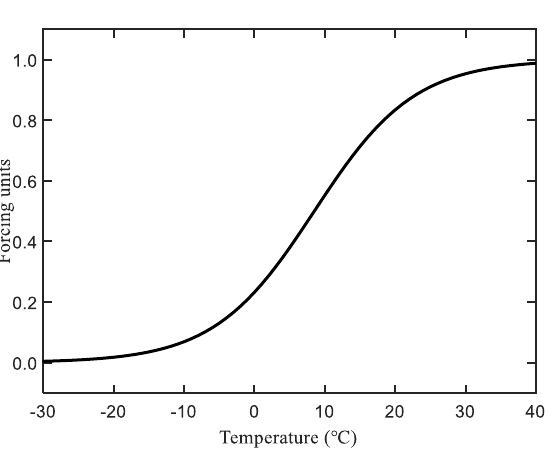
Figure 2. The response functions of chilling effect to daily mean temperature for Kobresia pygmaea alpine meadow